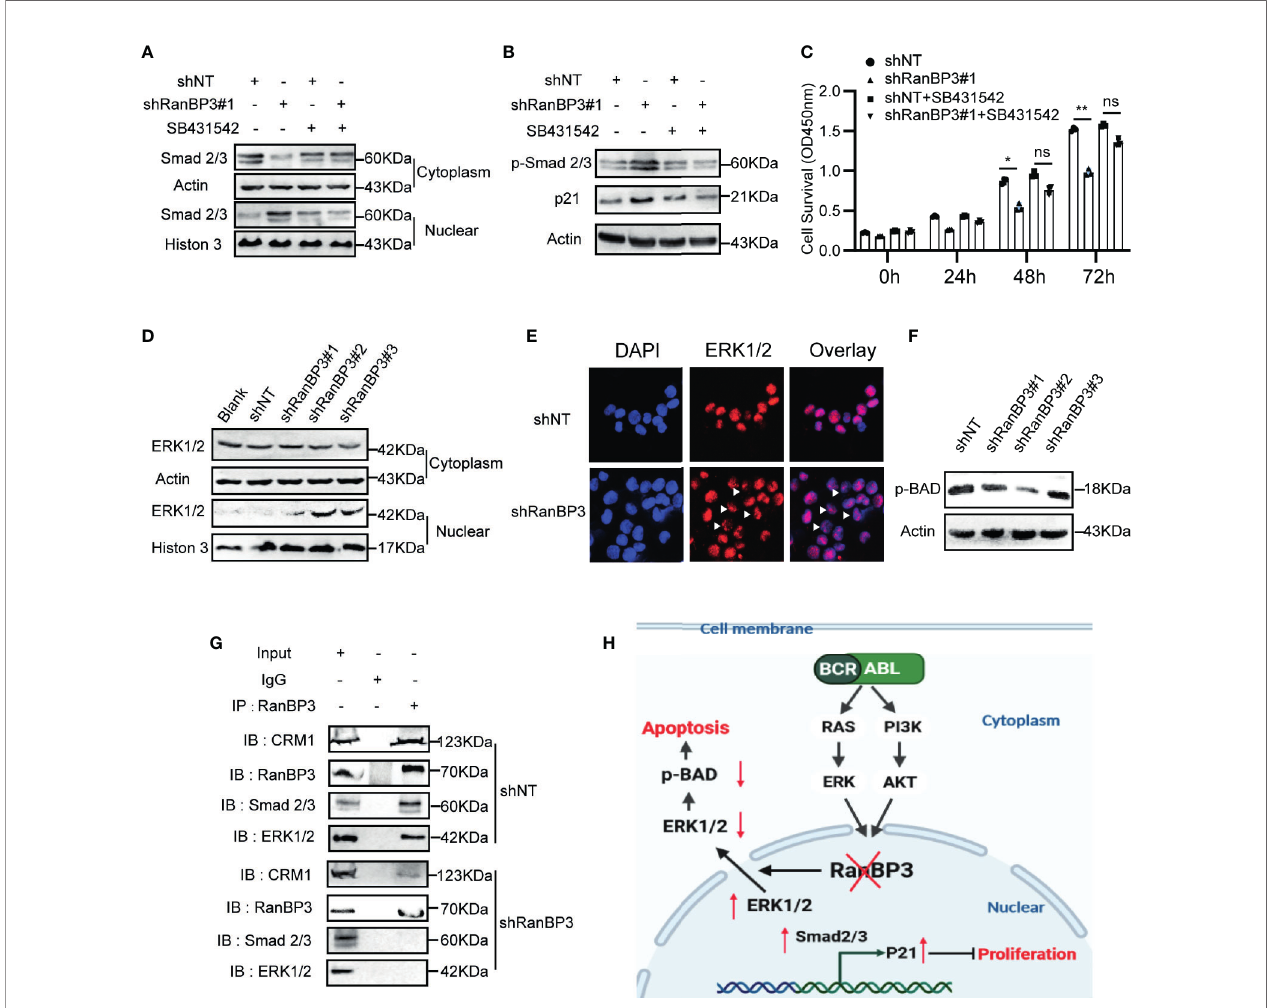
FIGURE 6 | RanBP3 regulates cell proliferation and apoptosis by mediating the nuclear transport of SMAD2/3 and ERK1/2. K562-shRanBP3 and K562-shNT were treated with DMSO or 10 m M SB432542 for 8h. (A) The nuclear and cytosol proteins were extracted and used for the detection of SMAD2/3 by western blot. (B) Total proteins were obtained for the detection of p-SMAD2/3 and p21 levels. (C) Cell survival was determined by CCK-8 at the indicated time. The cytoplasmic and nuclear distribution of ERK1/2 was analyzed in K562-ShRanBP3, K562-shNT and K562 by western blot (D) and immuno fl uorescent (E) . (F) The expression of p (ser112)-BAD was determined in K562-ShRanBP3 and K562-shNT cells. (G) CO-IP assay was performed using the antibody anti-RanBP3 to examine the interaction of proteins in K562-ShRanBP3 and K562-shNT cells, and the RanBP3-bound proteins were determined by anti-ERK1/2, anti-CRM1, and anti-SMAD2/3 antibody. An anti-Rabbit IgG antibody was used as the negative control. (H) The working model for RanBP3 silencing-mediated proliferation and apoptosis in CML. RanBP3 is a downstream molecule of BCR-ABL and regulates SMAD2/3 and ERK1/2 nuclear export. After the knockdown of RanBP3, nuclear SMAD2/3 increased followed by the enhanced levels of p21, which inhibited cell proliferation, and the decreased cytoplasmic ERK1/2 levels relieved the antiapoptotic effect of p-BAD in CML. *p < 0.05, **p < 0.01 and ns means no signi fi